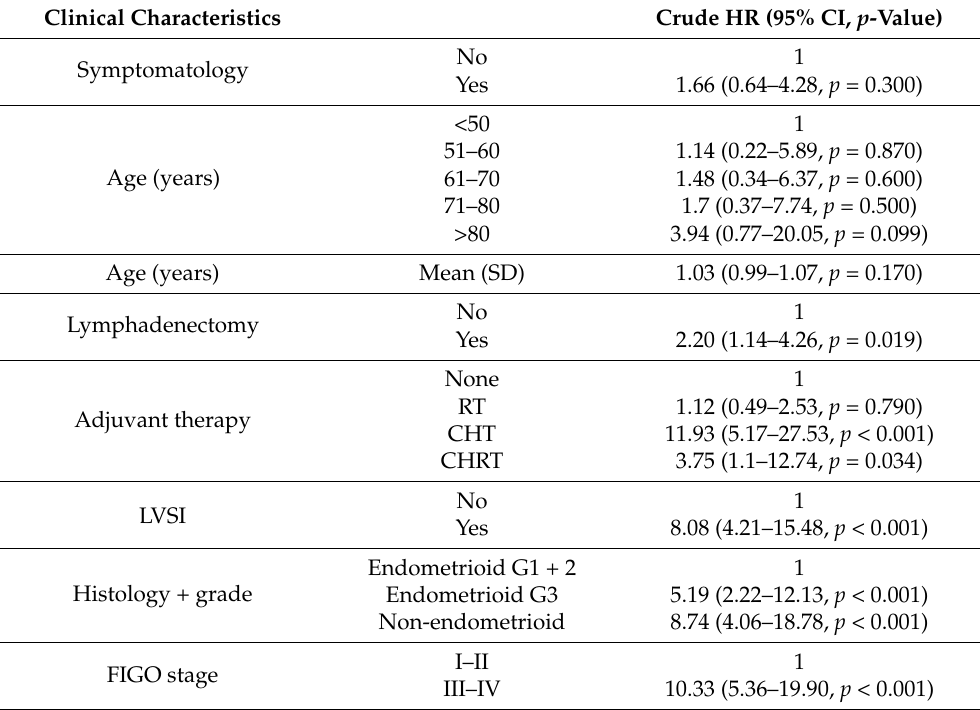
Table 4. Disease-specific survival—univariable model of cumulative incidence with competing risk. Clinical